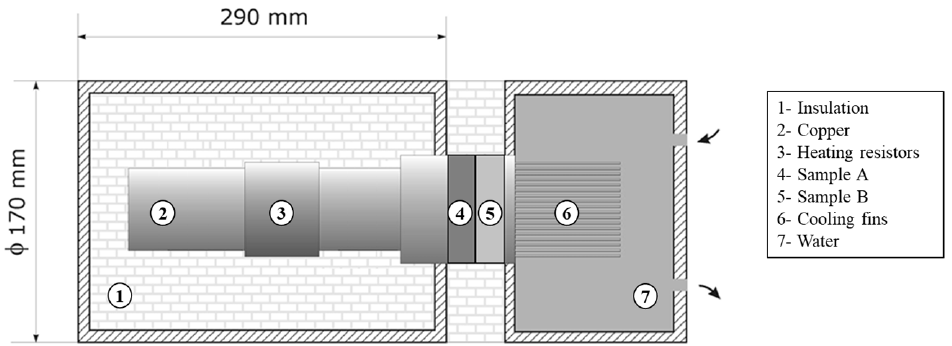
Figure 2. Heat transfer equipment.